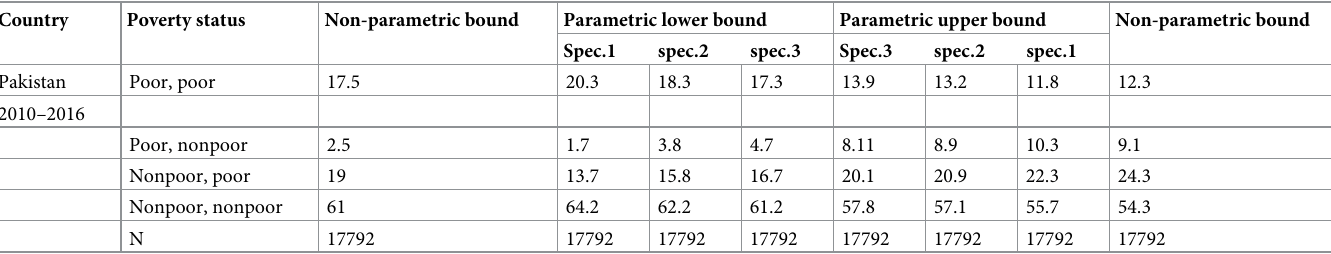
Table 4. Poverty dynamics estimates from synthetic panel data for Pakistan with partially simulated errors.